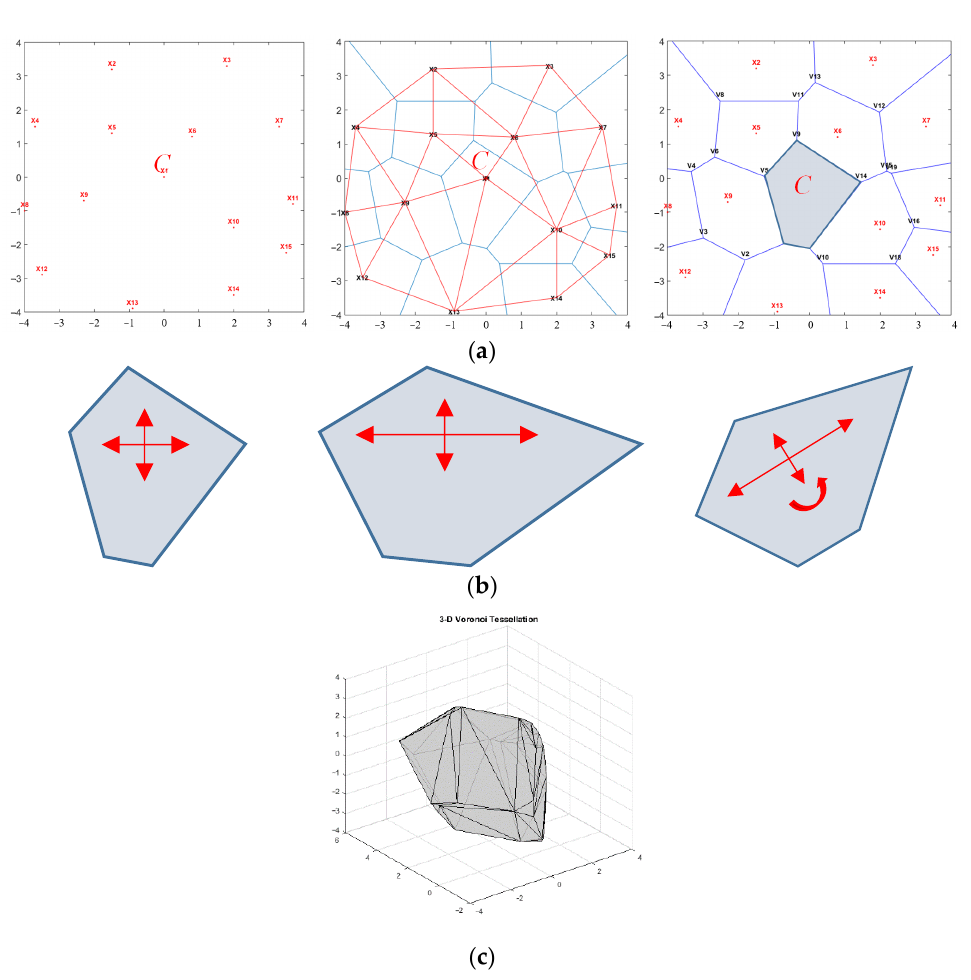
Figure 5. Particle reconstruction based on Voronoi tessellation: ( a ) basic particle shape generation; ( b ) spindle tension and rotation for shape adjustment; ( c ) 3D particle shape for